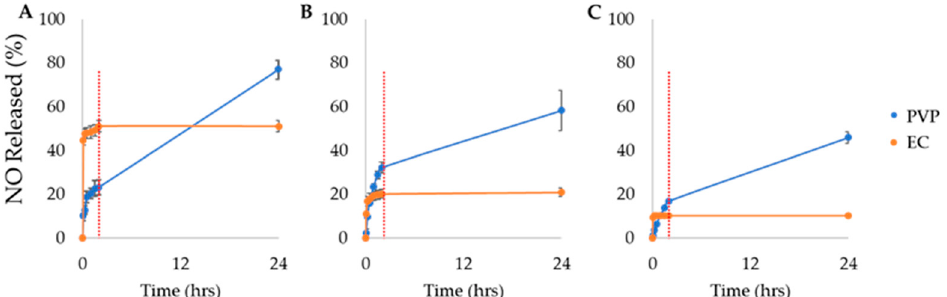
Figure 2. In vitro release of NO from NO-fibers fabricated with PVP or EC over 24 h. The percent NO released from NO-fibers containing PROLI–NONOates ( A ), DPTA–NONOates ( B ), and DETA– NONOates ( C ). Red lines indicate 2 h marks. Data are shown as mean ± standard deviation (SD).